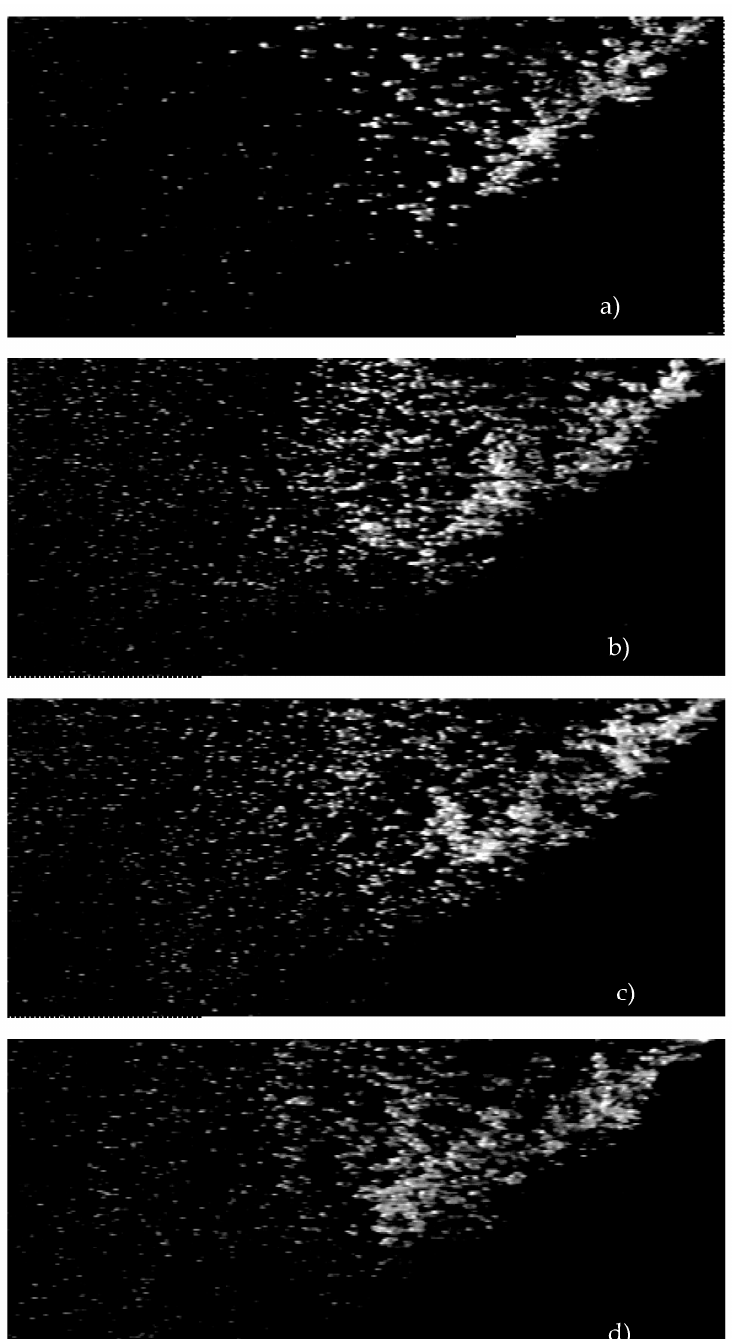
Figure 5. Bubble clouds in fresh and saline water: ( a ) S = 2 psu; ( b ) S = 13 psu; ( c ) S = 25 psu; ( d ) S = 38 psu. Experimental conditions and monitored variables are given in Table 1 and Figure 4. The visualizations show that the overall shape of the envelope of the bubble cloud is the same for fresh or more saline water. Also evident is that there are fewer bubbles at the left-hand side for fresh water (panel ( a )).